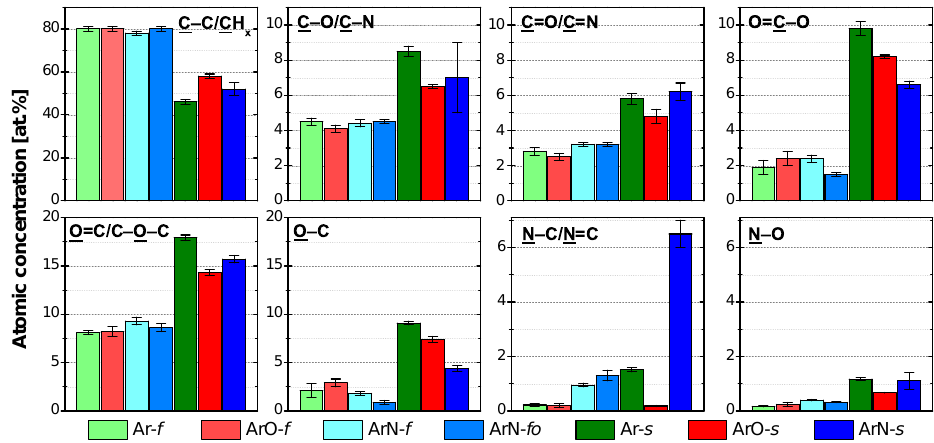
Figure 3. XPS C1s, O1s, and N1s high-resolution spectrum components and their atomic concentra- tions for the plasma-treated PP samples. Spectra were measured right after the plasma